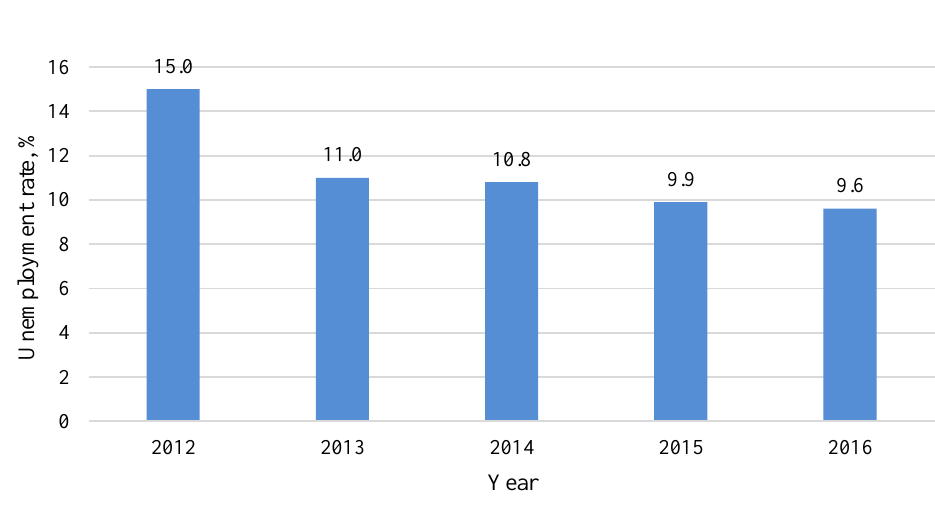
Fig. 1. Unemployment rate for the period of 2012–2016 in Latvia (Central Statistical Bureau, n. d.).